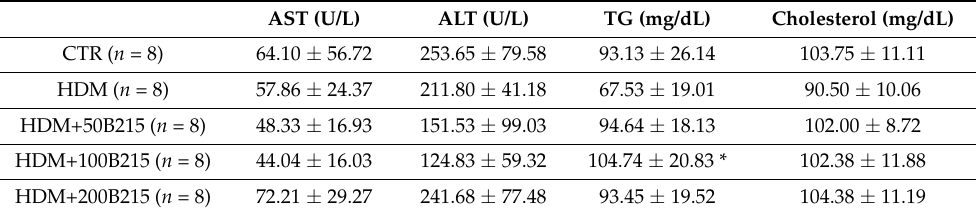
Figure 3. Effect of B215 on body weight in HDM-induced lung inflammation. ( A ) Body weight ( B ) Percentage change in body weight. Gray, Control; Black, HDM; Light blue, HDM+50B215; Blue, HDM+100B215; Dark blue, HDM+200B215. Data are presented as mean ± SD (# and *, p < 0.05, compared to CTR and HDM, respectively). ns; not significant. Table 2. Effect of B215 on plasma biochemical parameters in HDM-induced mice.